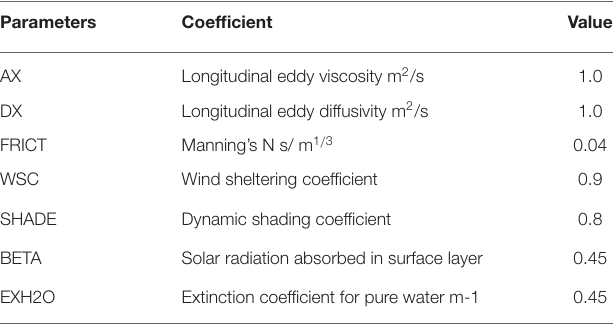
TABLE 1 | The main control parameters of the hydrodynamic model in the Xiangxi Bay. Parameters